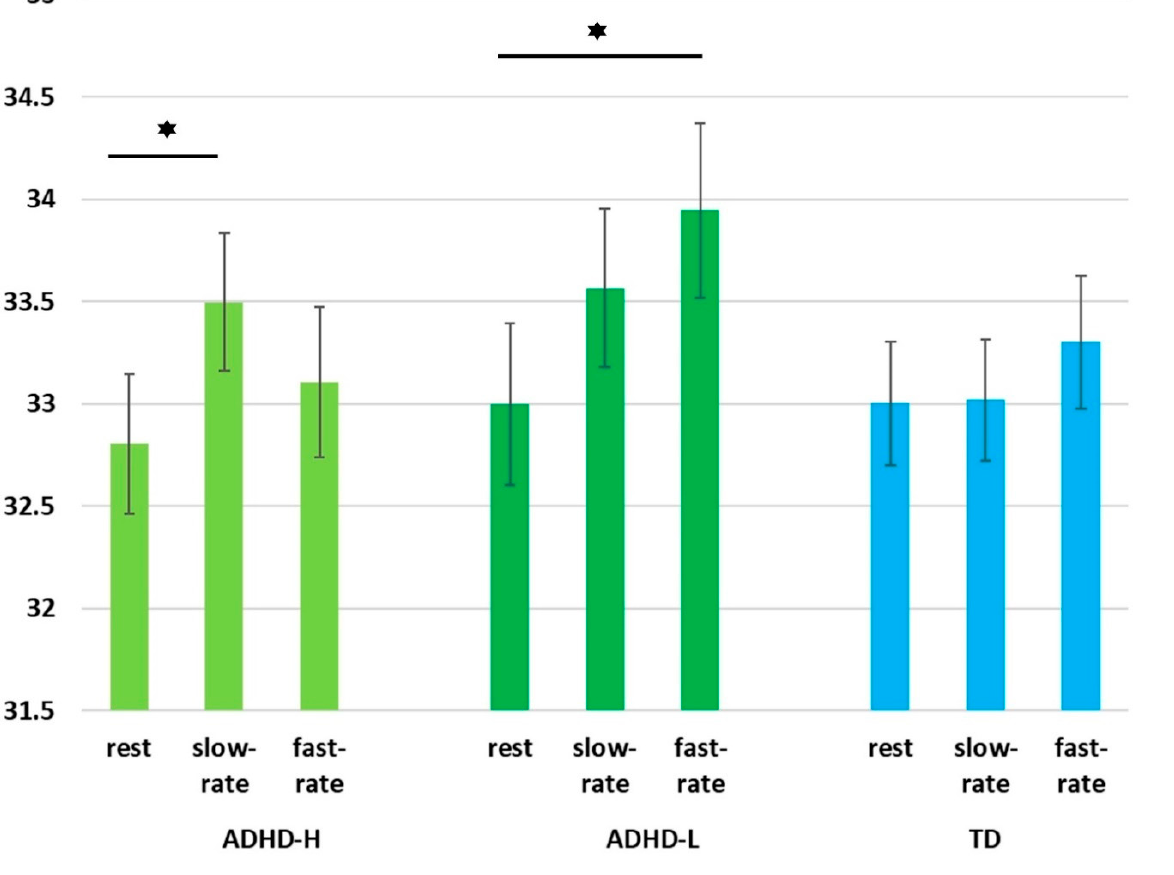
Figure 8. The concept of clinical application.